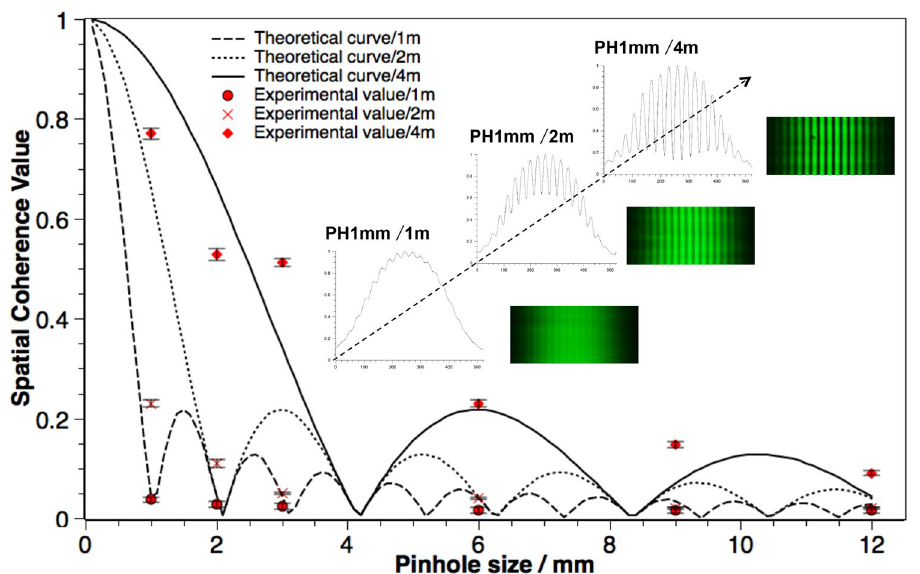
Figure 8. Theoretical spatial coherence values and corresponding experimental values for green LED with pinholes of different size, propagating in free space with distance of 1 m, 2 m and 4 m. Top right embedded graph shows the interference patterns and its averaged cross-section intensity distribution for 1mm pinhole at distance of 1 m, 2 m and 4